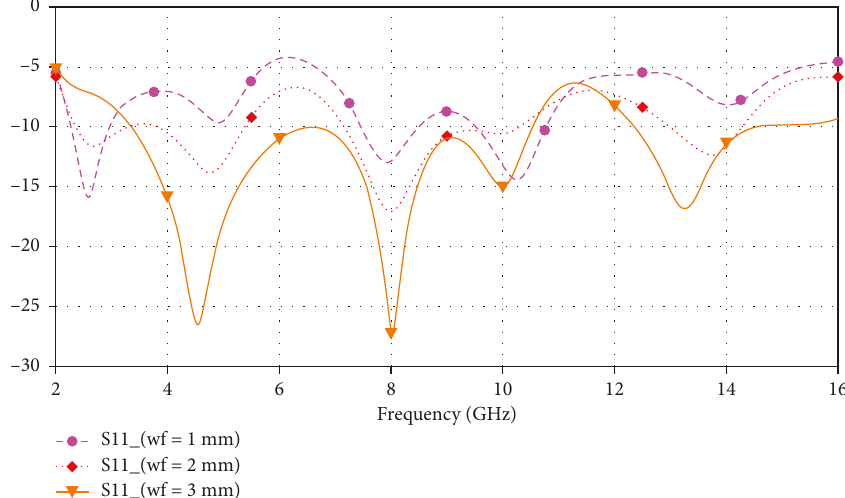
Figure 6: Parametric analysis-feed width